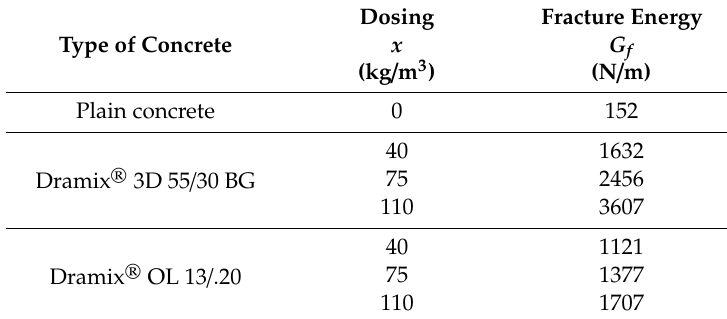
Table 4. Fracture